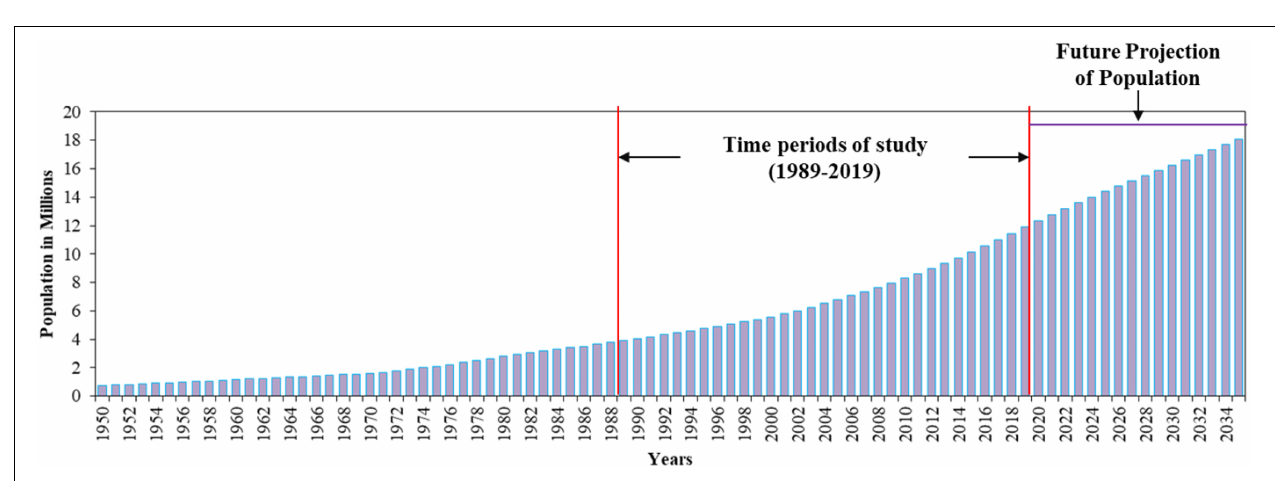
FIGURE 7 | Comparison of overall LST mean and difference of LST mean among IS and VS between Bengaluru and other global cities (including other Indian cities) (Liu and Weng, 2008; Kong et al., 2014; Estoque et al., 2017; Estoque and Murayama, 2017; Ranagalage et al., 2018a,b; Rousta et al., 2018; Priyankara et al., 2019; Simwanda et al., 2019; Sultana and Satyanarayana, 2020).